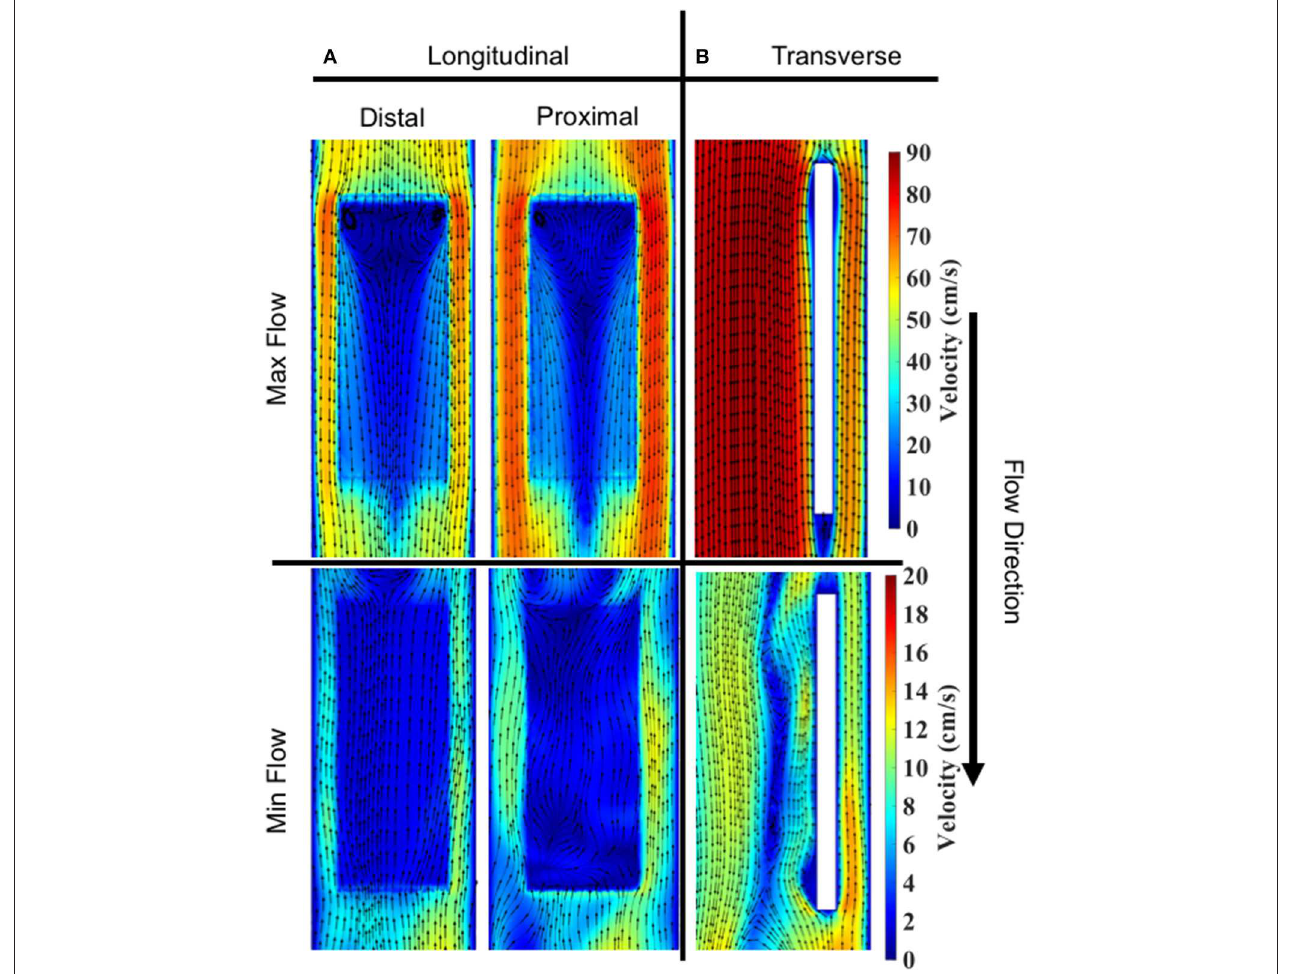
FIGURE 8 | Velocity contours and streamlines on specimen #2. Max and min flow corresponded to ∼ 0.368 and ∼ 0.83 s, respectively, in the enforced velocity waveform. (A) Longitudinal slice showing a comparison of streamlines on distal vs. proximal surfaces. Cut planes were taken 200 µ m above and below the specimen to extract velocity contours. (B) Transverse slice showing a comparison of streamlines during Max vs. Min flow. Cut planes were taken through the center of specimen.